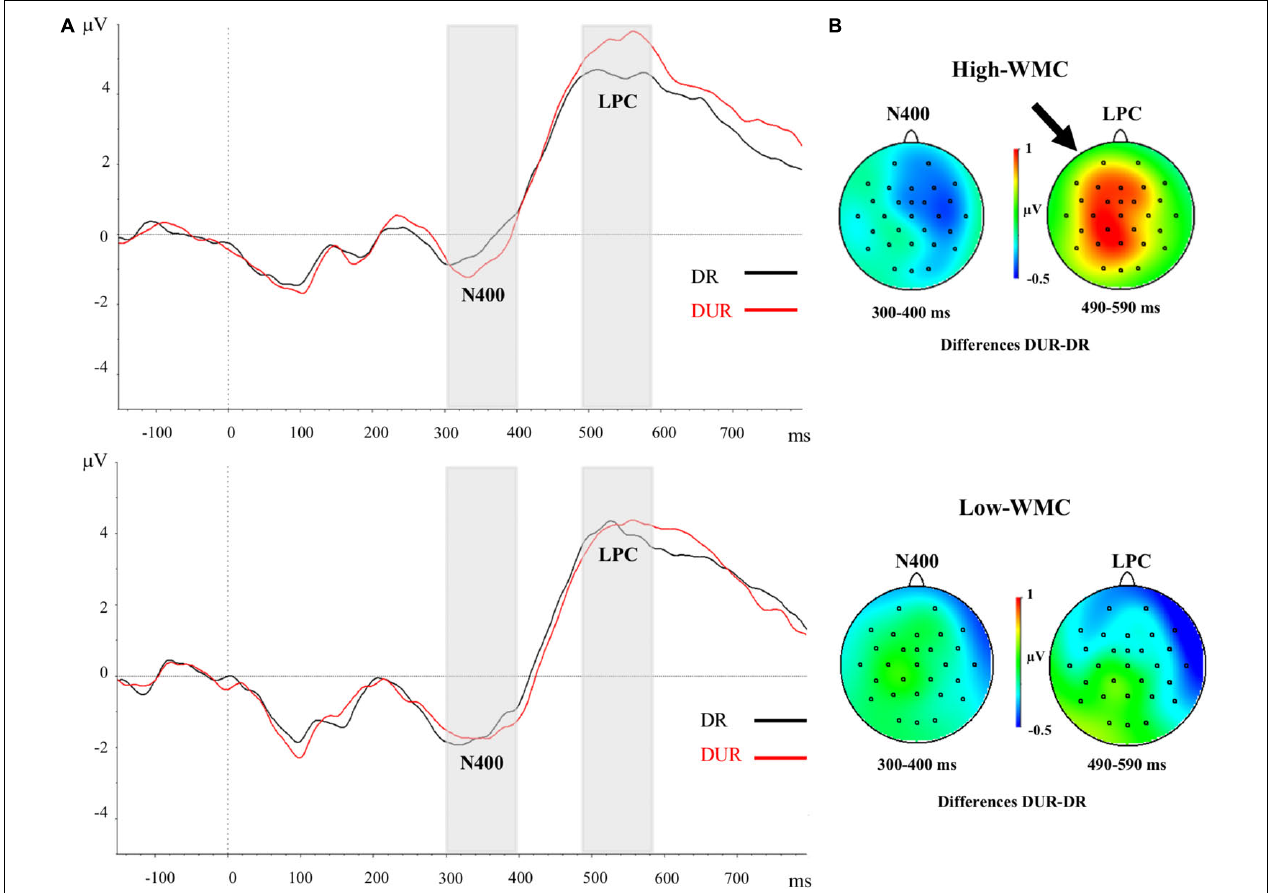
FIGURE 4 | (A) Grand-averaged voltage data (in µ V) in the Delayed Masking condition as a function of WMC and Prime-Target Relatedness (Related-R, black line, vs. Unrelated-NR, red line). As statistical analyses did not yield significant effects of the laterality and caudality factors, voltages were collapsed across the nine fronto-central and centro-parietal electrode sites (FC1/FC2, C3/C4, P3/P4, FCz, Cz, Pz). The analyzed epoch lasted from 150 ms before the onset of the target to 700 ms after target onset. Negative potentials are plotted downwards. Vertical gray shadings above the X -axes indicate the 300–400 ms (N400) and 490–590 ms (LPC) time windows used for statistical analysis. (B) Topographic voltage maps across the 29 electrode sites, displaying the ERP priming differences (unrelated minus related trials) in the delayed masking condition. The small arrowhead toward the top of the voltage map highlights the topography for the LPC correlate averaged in the time window between 490 and 590 ms, but this ERP effect was significant only in the High-WMC group. DR, Delayed Related; DUR, Delayed